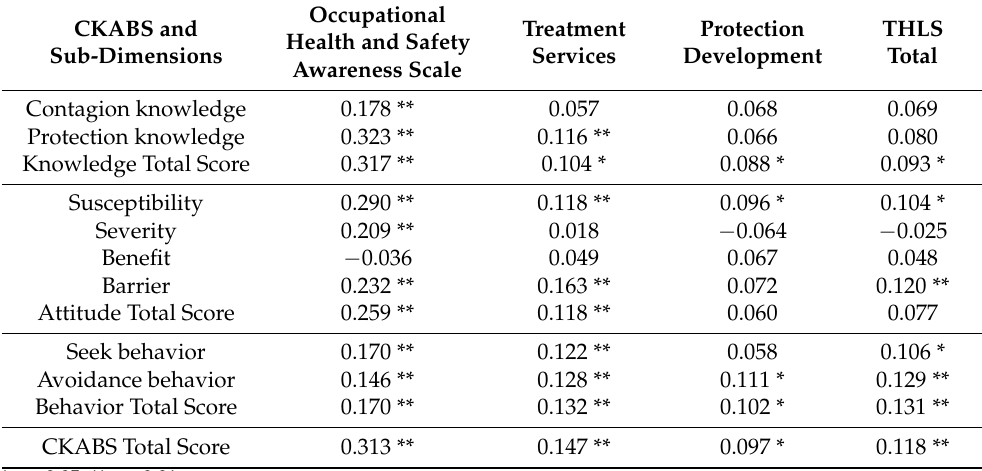
Table 4. Correlation between Occupational Health and Safety Awareness Scale and THL Scale and CKABS.